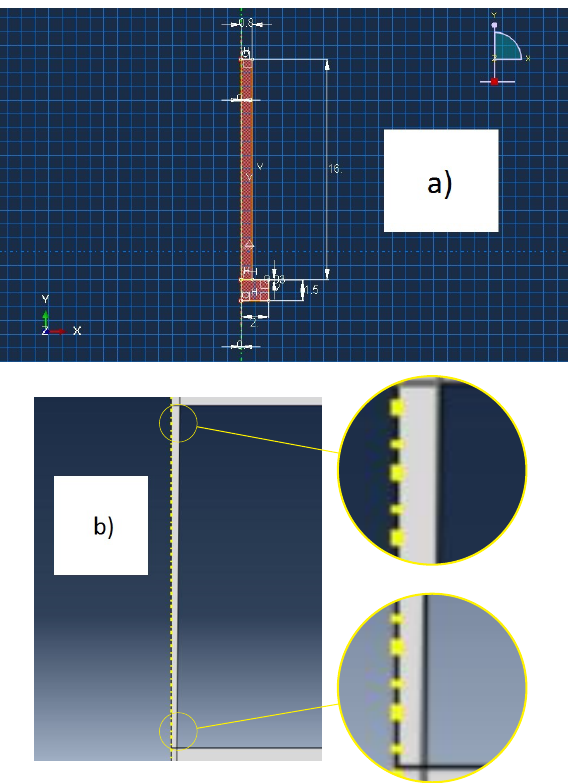
Figure 2. ( a ) Model sketch; ( b ) Shape of the Figure 2. (a) Model sketch; (b) Shape of the gap. The most relevant material properties for this model had to be specified in Table 1.